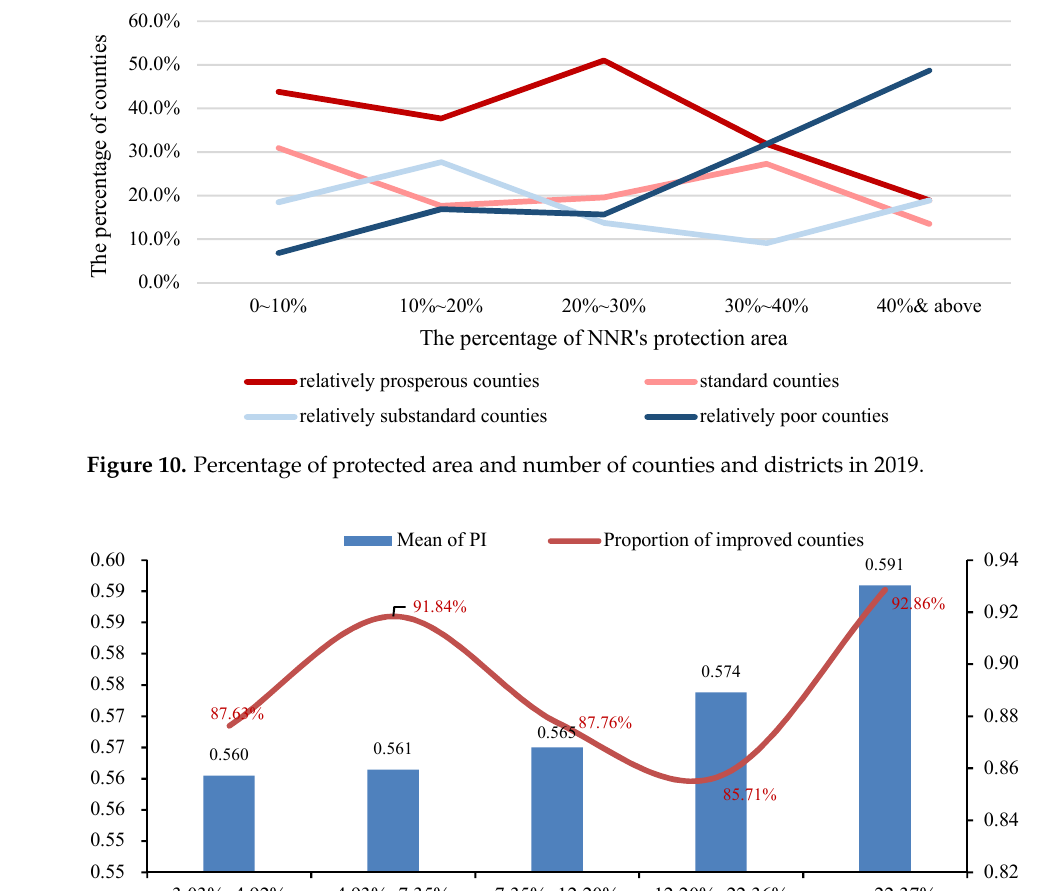
Figure 11. Percentage of the PI in groups of PA counties.